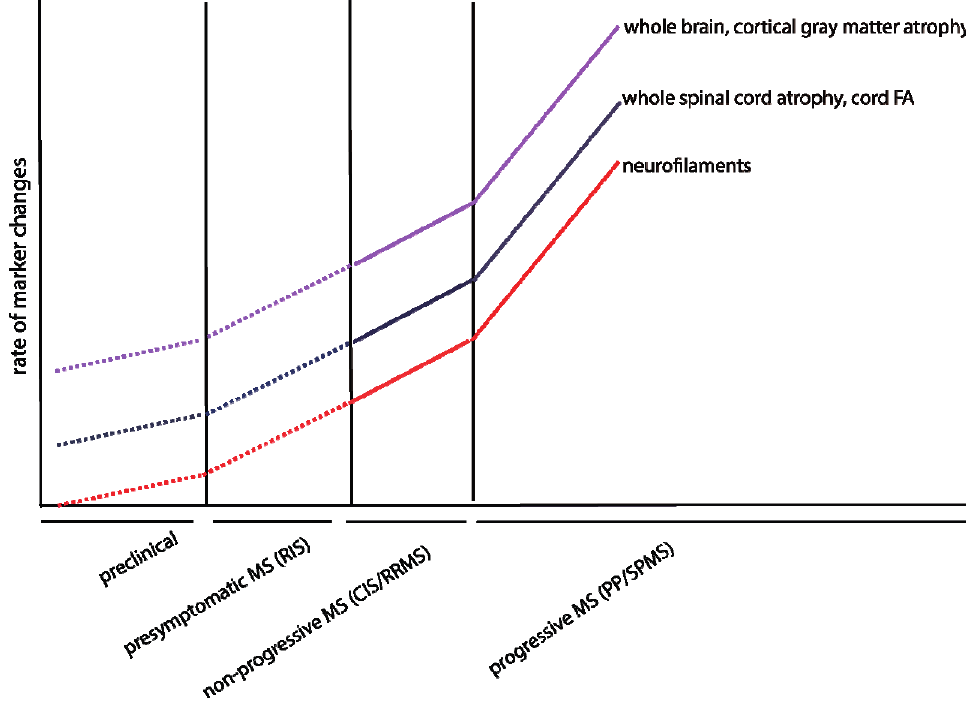
Figure 4. Dynamics of CSF and MRI-parameters of neurodegeneration over the course of the multiple sclerosis (MS). The imaging studies revealed accelerated whole brain, spinal cord and cortical gray matter atrophy in the progressive phase of MS when compared to relapsing remitting multiple sclerosis (RRMS) and clinically isolated syndrome (CIS). Similarly, decrease in cord FA was higher in PPMS compared to RRMS. According to these results, similar changes in the levels of neurofilaments could be